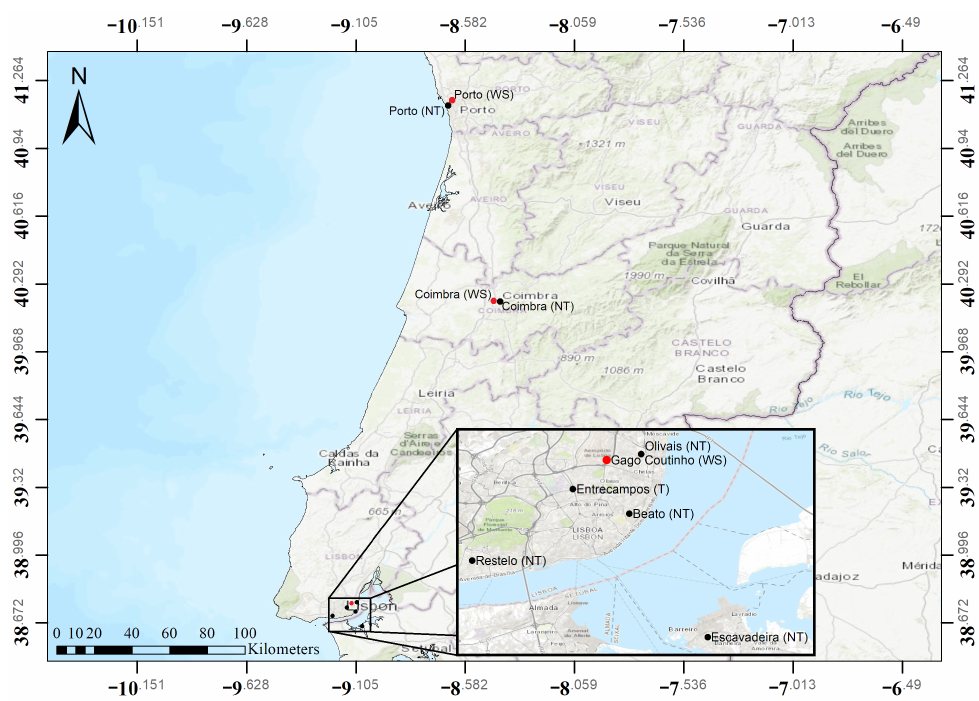
Figure 6. Map of all AQMS in study in Portugal. Black dots are AQMS and red dots represent WS. The WS data was provided by IPMA. This includes hourly global radiation (GR), temperature, humidity, and precipitation. From this weather data, GR was selected as indicative of h ν in the photolysis reaction (4). Temperature is highly correlated with GR while precipitation was seen to have no impact on O 3 levels [4]. In Figure 6 we highlight Lisbon AQMS and show their location geographically as well as its closest WS (red dot). All hourly data is in the Greenwich Mean Time Zone. The parameters in study, geographic coordinates and the description of all monitoring stations can be seen in Table 1. Table 1. Parameters and type of monitoring stations in study. For geographical location of Lisbon AQMS see Figure 6. Monitoring